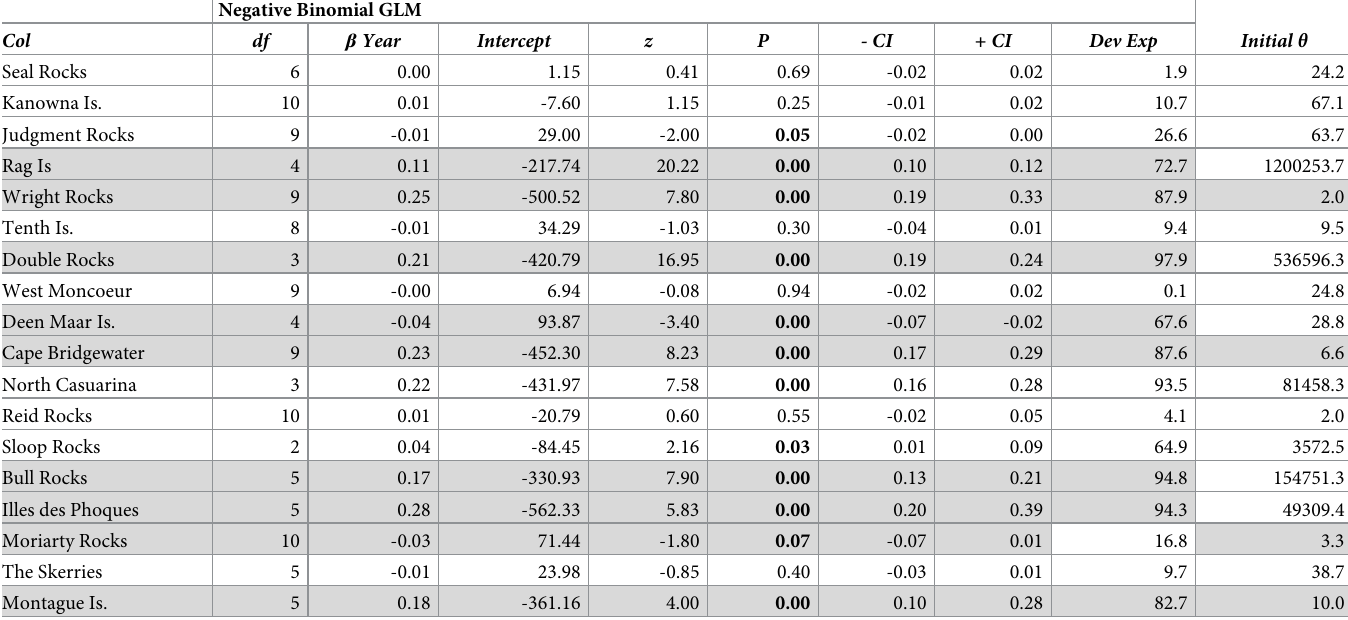
Table 3. Trends analyses from the Australian fur seal live pup abundance estimates including the 2017 census results using Generalised Linear Models. Negative Binomial distribution was applied to live pup abundance data presented in the S2 Table in S1 File; regression results are provided including the percentage deviance explained ( Dev Exp ) and the dispersion parameter ( Initial θ) of the GLM. The colonies ( Col ) with a significant result at the 0.10 level (shown in bold type), with a Dev Exp > 50 and/or Initial θ � 10 represent reliable results and are shaded. Sites are ordered to match Table 2 and Fig